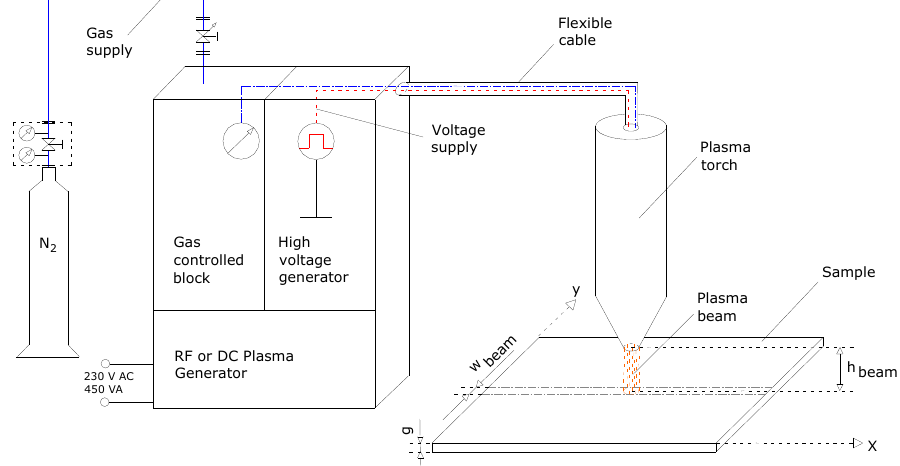
Figure 1. Plasma beam equipment for nitriding process of AISI 304 SS sample and geometrical parameters of the plasma beam.